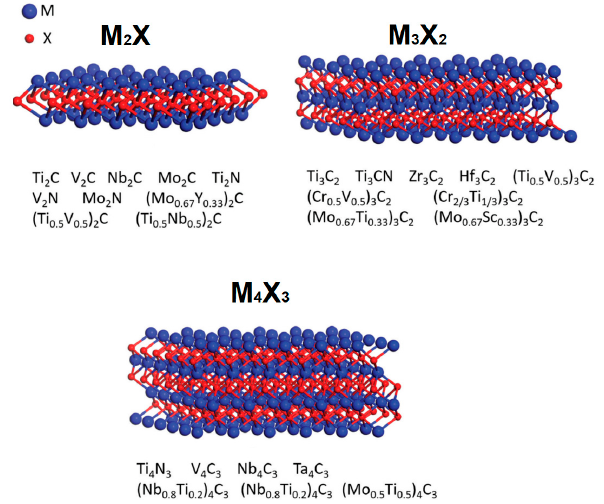
Figure 4. MXenes bare structures with an overview of all experimentally synthesized corresponding compositional samples. Reprinted with permission from [42]. Copyright © 2020, CC BY 4.0.